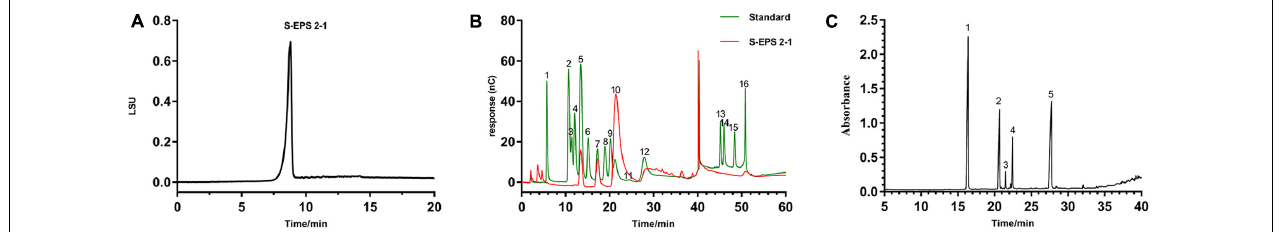
FIGURE 3 | (A) The HPSEC analysis of S-EPS 2-1. (B) The ion chromatography analysis of S-EPS 2-1. (1) Fuc, (2) GalN, (3) Rha, (4) Ara, (5) GlcN, (6) Gal, (7) Glc, (8) GlcNAc, (9) Xyl, (10) Man, (11) Fru, (12) Rib, (13) GalA, (14) GulA, (15) GlcA, (16) ManA. (C) Methylation analysis of S-EPS 2-1 by GS-MS. (1) 2,3,4,6-Me4-Manp; (2) 3,4,6-Me3-Manf; (3) 2,4,6-Me3-Manp; (4) 2,3,4-Me3-Glcp; (5) 3,4-Me2-Manp.